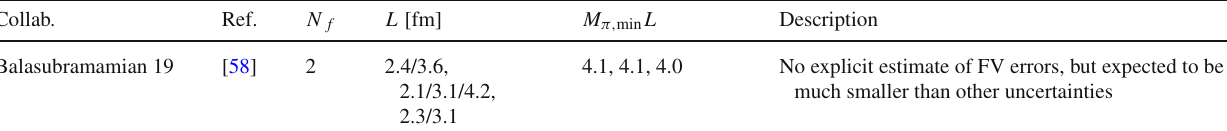
Table 143 Finite-volume effects in determinations of the B - and B s -meson decay constants for N f = 2 simulations. Each L -entry corresponds to a different lattice spacing, with multiple spatial volumes at some lattice spacings Collab.